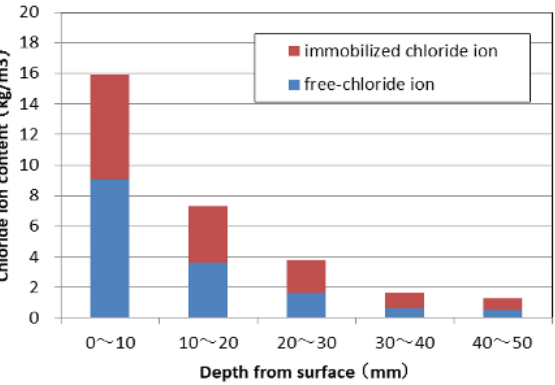
Figure 5. Chloride ion profile for